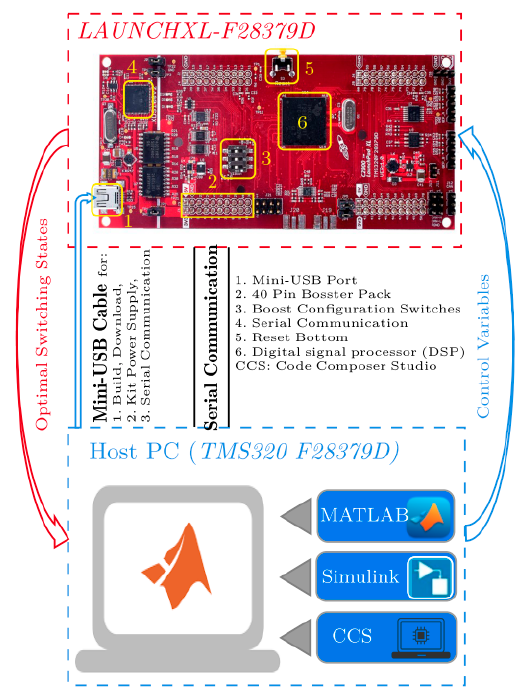
Figure 10. Schematic diagram of the HIL simulation based on the DSP target Launch- PadXLTMS320F28379D